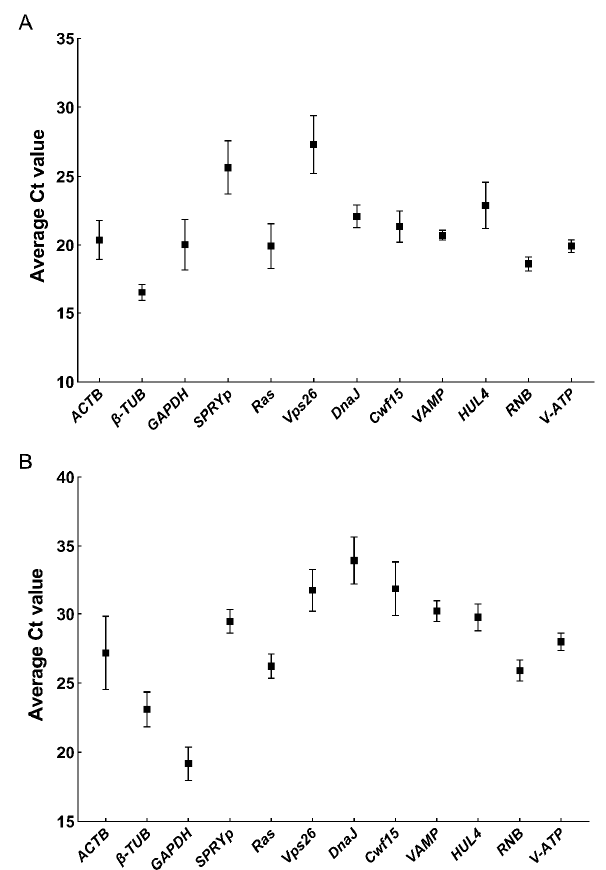
Figure 1. Variation in RT-qPCR value of 12 ICGs in samples of F. filiformis and N. crassa . ( A ) Average Ct value of each ICGs in 10 samples of F. filiformis (10 developmental stages samples of in the F. filiformis dikaryotic strain FL19: mycelia, aerial hyphal knot, primordia, bud, pileus in the young fruiting body, stipe the in the young fruiting body, pileus in elongation stage, stipe in elongation stage, pileus in maturation stage and stipe in maturation stage) were shown on the y-axis. The 12 ICGs candidates were shown on the x-axis. Error bars represent the maximum Ct value and the minimum Ct value, respectively. ( B ) Average Ct value of each ICGs in eight samples of N. crassa (WT; ∆ Spds; BT; BS; CS; HS; JA; H 2 O 2 ) were shown on the y-axis. The 12 ICGs candidates were shown on the x-axis. Error bars represent the maximum Ct value and the minimum Ct value, respectively.